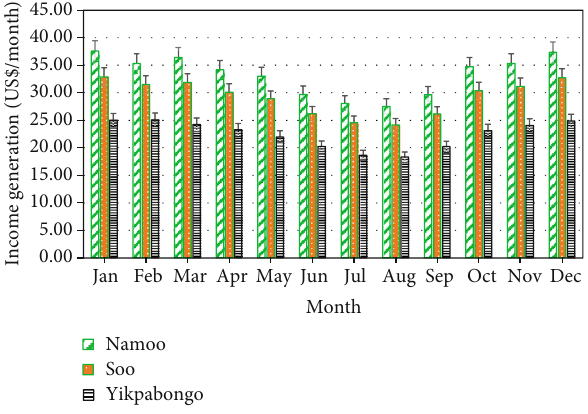
Figure 5: Income generation from excess PV electricity